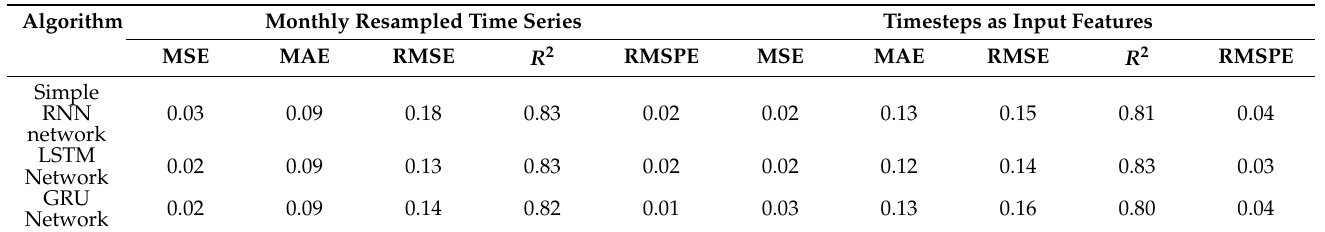
Table 8. Results when forecasting from all numerical OCT features, from two previous visits.